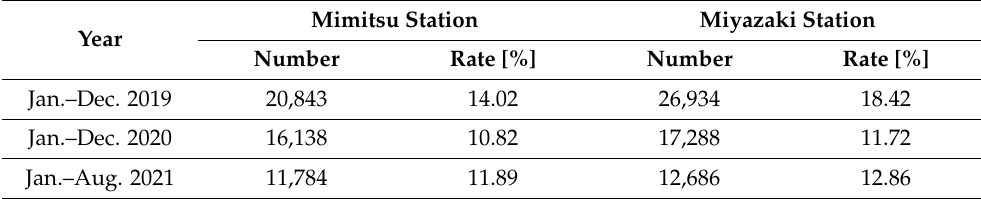
Table 2. Classification results for double-peak spectra from January 2019 to August 2021.